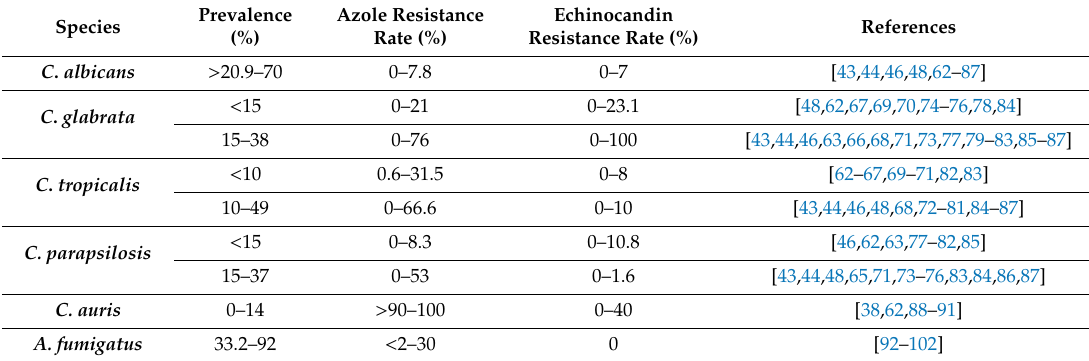
Table 1. The epidemiology of candidemia and invasive aspergillosis and antifungal resistance rates determined for selected Candida species and Aspergillus fumigatus